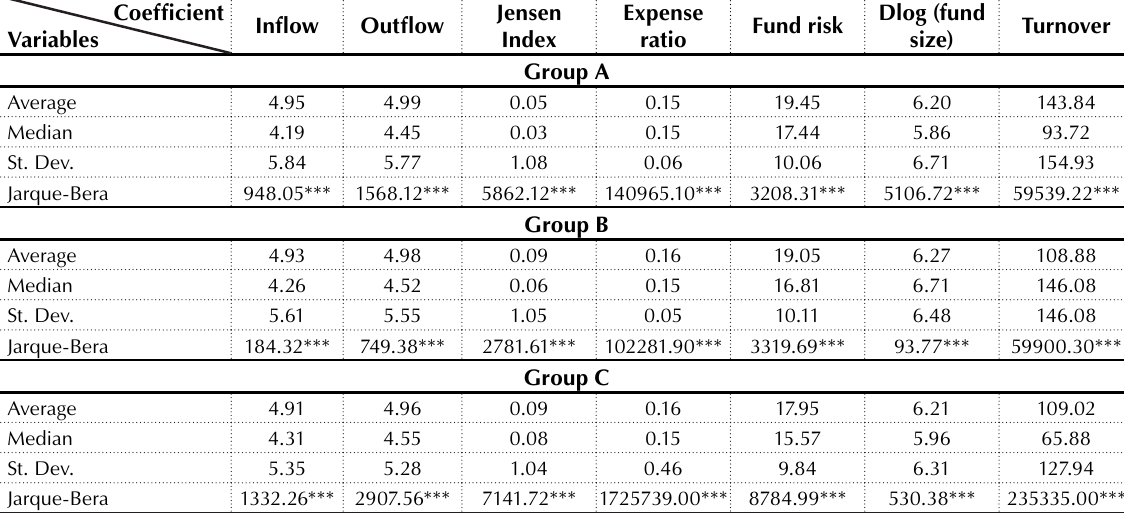
Table 2. Fund performance statistics